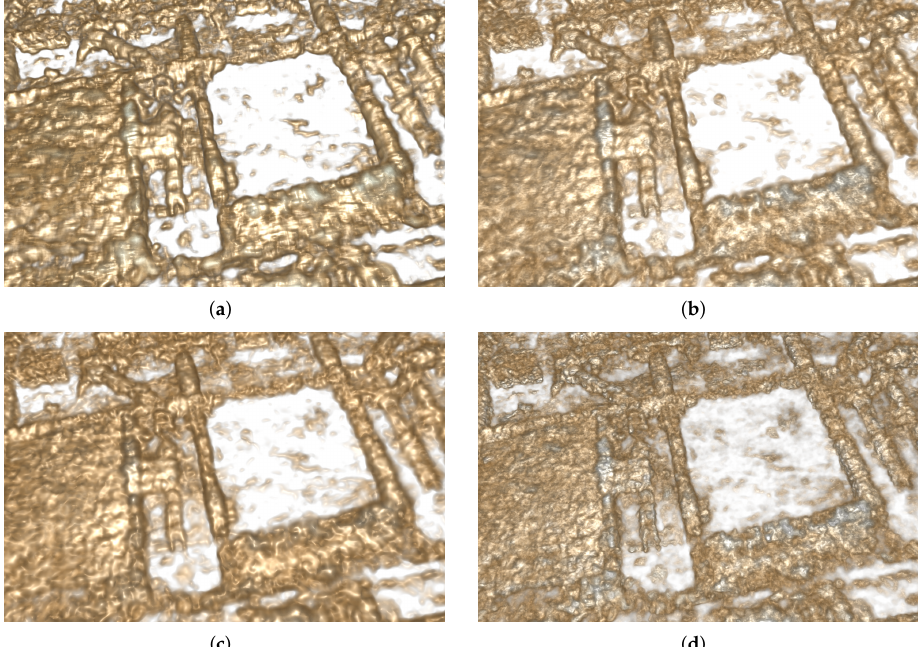
Figure 8. Direct volume rendering of GPR datasets filtered with a 3D median filter of kernel size 5 ( a ), a bilateral filter ( b ), an edge-enhancing anisotropic diffusion filter (EED) ( c ) and a TV-L1 filter λ = 0.75 ( d ). The outlines of the walls, sewerage ducts, and paved floors are clearly visible in all images. The blur level introduced by the median filter seems to be generally higher and it is respecting the shape edges of archaeological features to a lesser extent. The EED filter delivers very similar results to the bilateral filters. The TV-L1 filter results appear more detailed since blurring of structure boundaries is largely